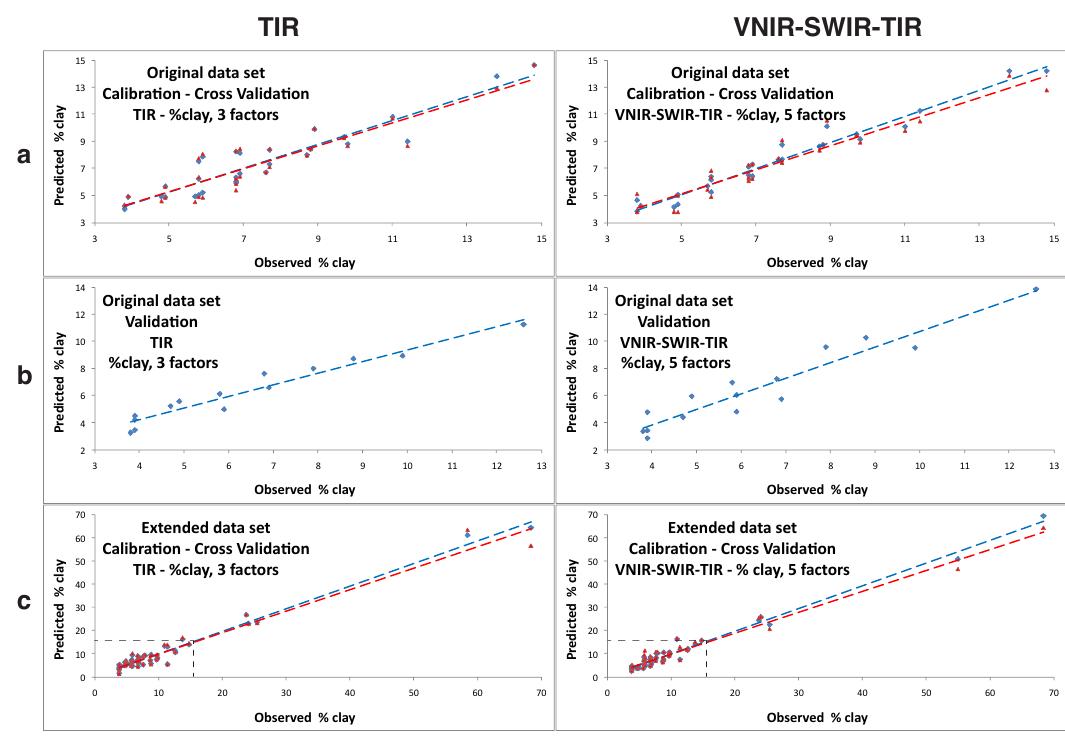
Figure 6. Observed (reference) clay content versus clay content predicted from the PLSR models for the TIR and the VNIR-SWIR-TIR spectral regions. ( a ) calibration (red) and internal cross-validation (blue); ( b ) external validation using a test dataset (blue) for the original dataset; ( c ) the results for the external dataset, calibration (red) and internal cross-validation (blue), where the dashed bordered area displays the data range from the original dataset. TIR